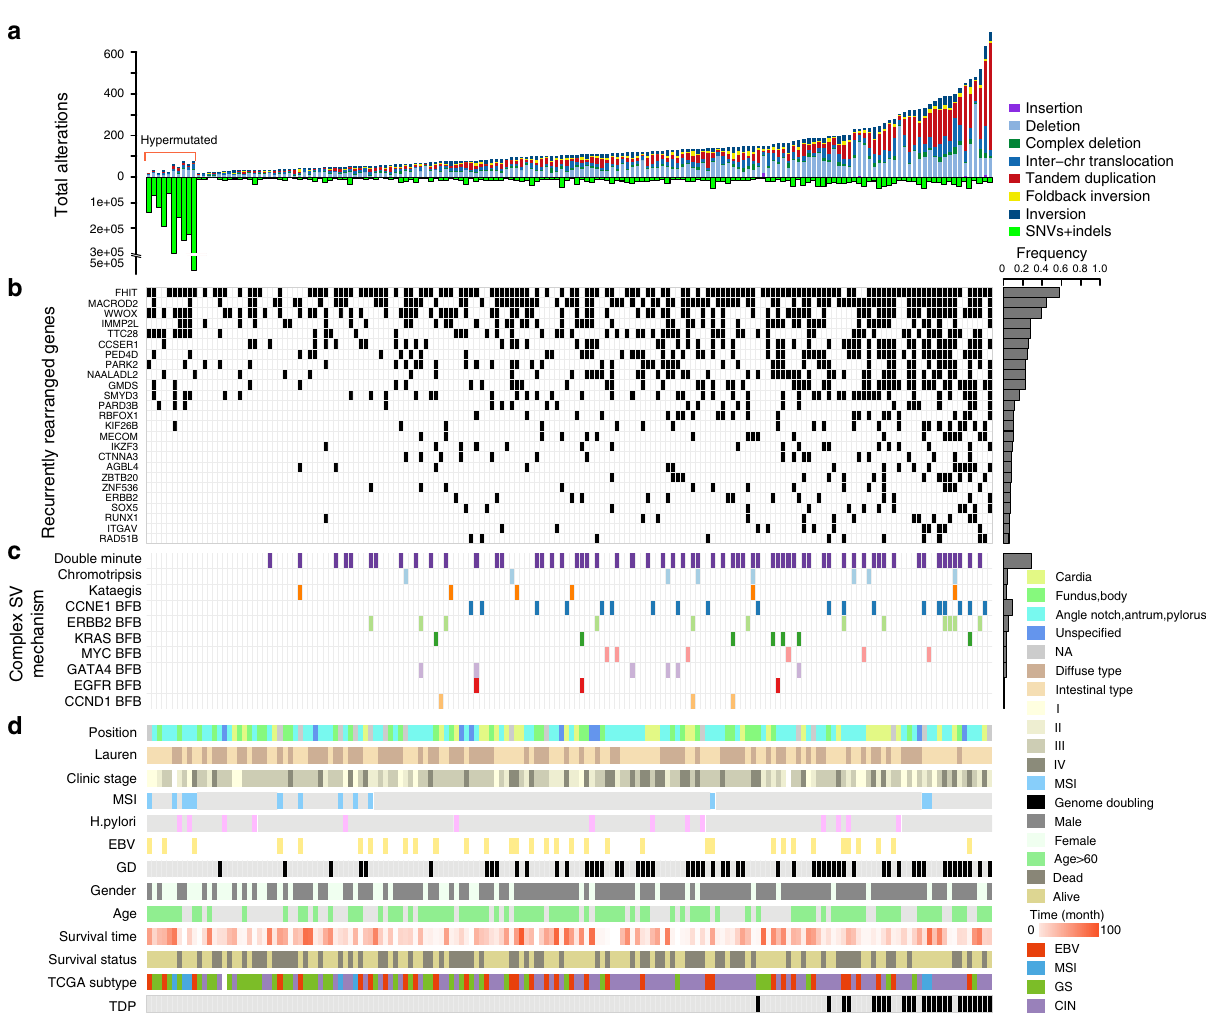
Fig. 1 Summary of SVs in GC. a The total number of structural changes (above the 0 axis) and point mutations or indels (below the 0 axis) for 168 GC specimens resident in hypermutated and regular-mutated GCs. b Genes from at least ten samples that underwent rearrangement. c Presence of localized complex SVs. d Clinical characteristics of 168 GC patients. SV structural variation, GC gastric